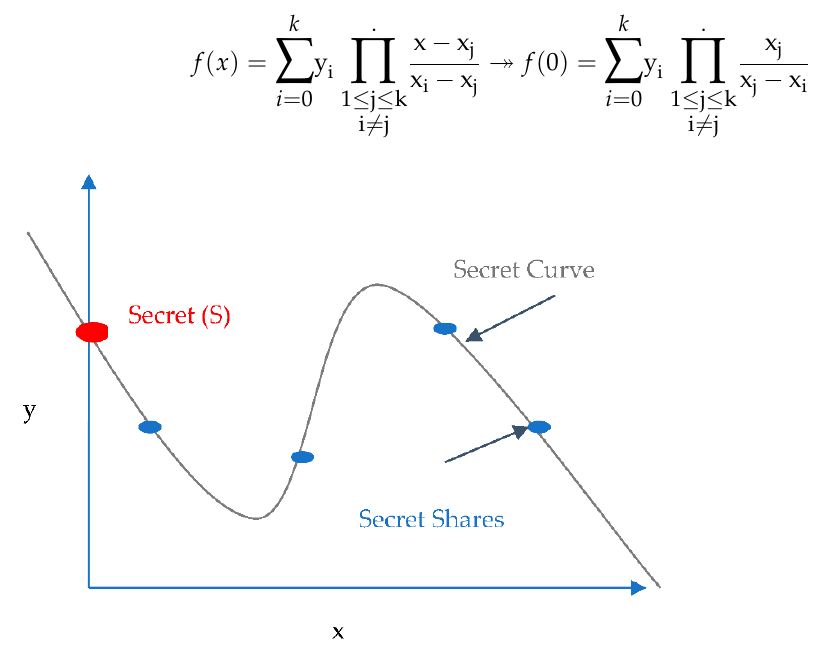
Figure 2. Lagrange interpolation.